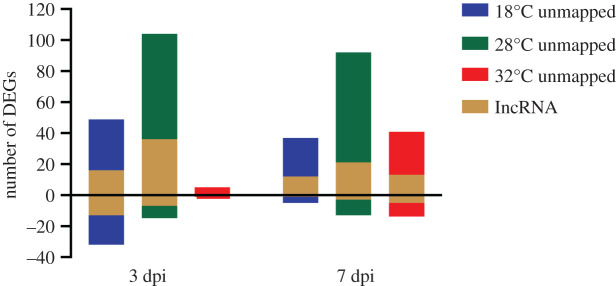
Number of differentially expressed genes (DEGs) that could not be mapped with DAVID bioinformatics cloud map. The number of lncRNA genes is shown within the total DEGs.